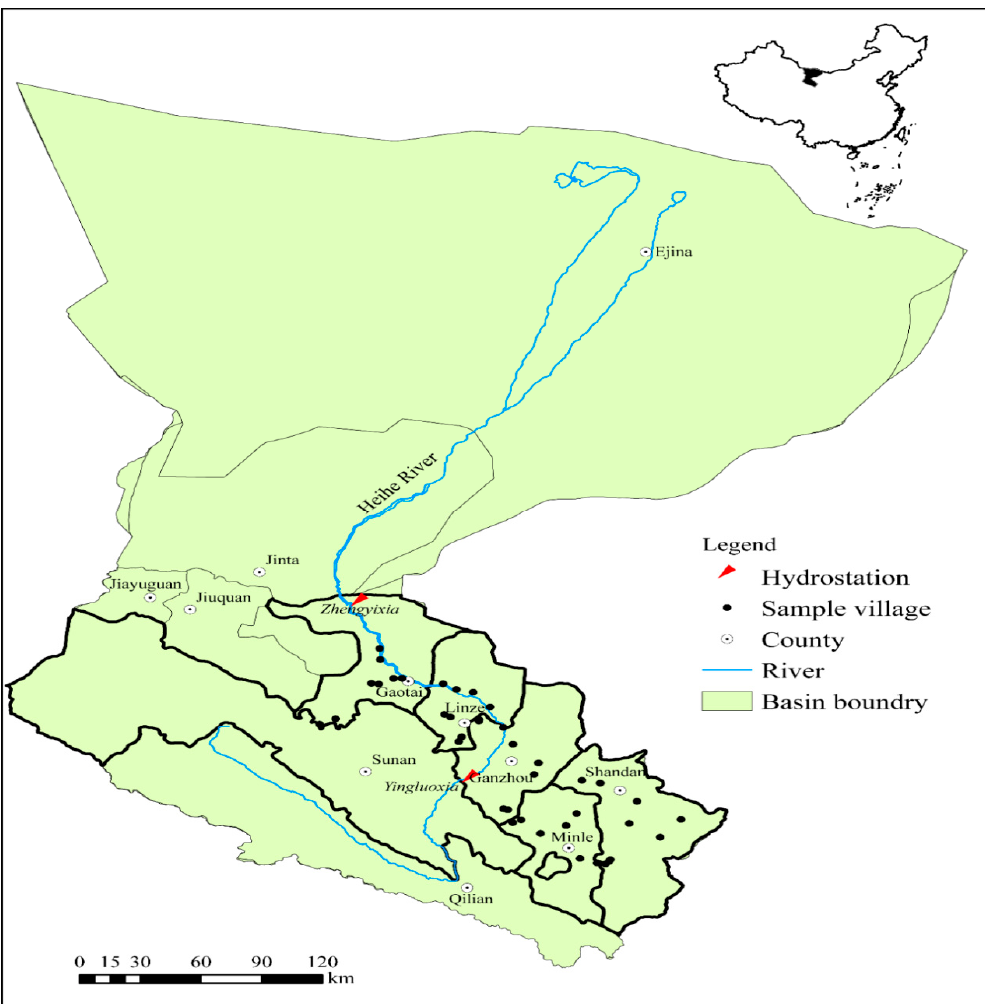
Figure 1. Study region and sample villages.